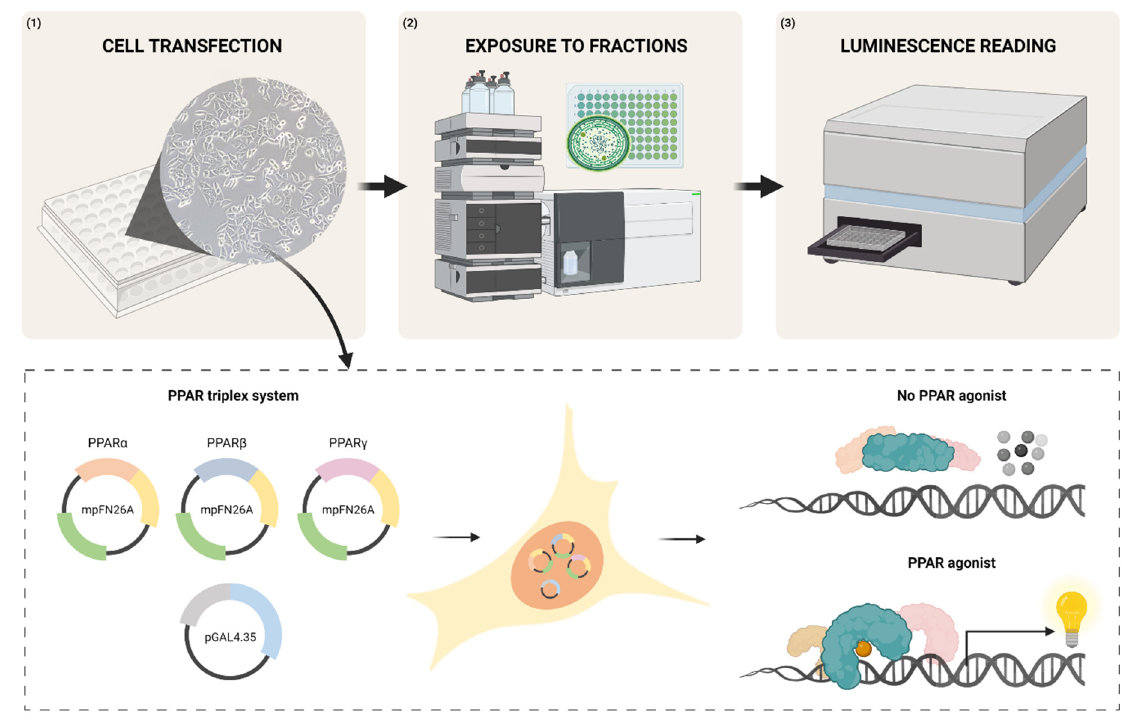
Figure 1. Schematic description of the transactivation assays methodology. (1) COS-1 cells are co- transfected in 96-well plates, with the vectors of the sensor system to be used, using Lipofectamine ® 2000 (Invitrogen™); (2) After 5 h, COS-1 cells are exposed for 24 h either to solvent control, to the reference agonists of each PPAR, or to the samples to be tested; (3) The luminescent activity of each vector’s luciferase is quantified, using the respective luciferase reporter kit in a microplate reader.